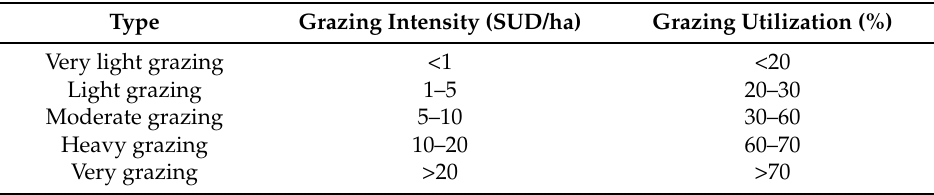
Table 1. Standard of grazing